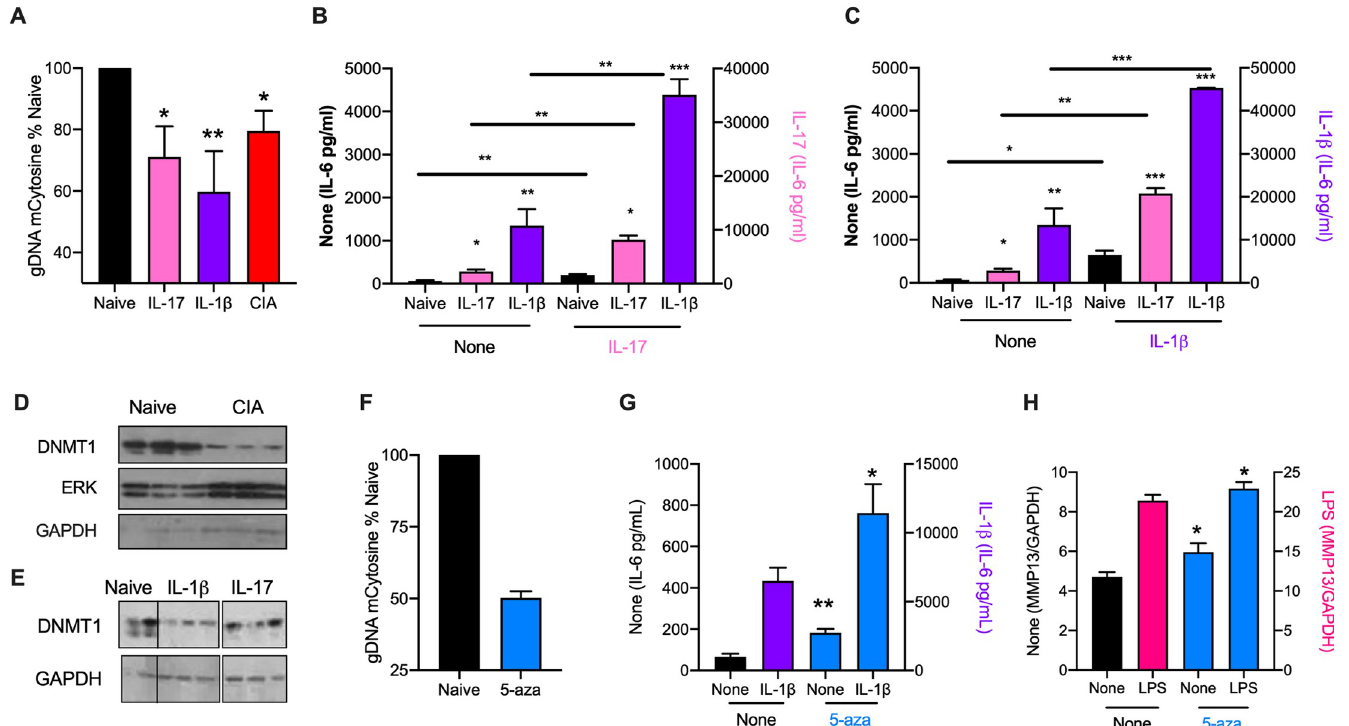
Fig 2. IL-1 β and IL-17 rewire na ï ve SFs to a CIA-like phenotype. (A) Global methylation status of Na ï ve-SFs incubated in medium alone (Na ï ve) or chronically treated with IL-17 or IL-1 β , compared to that of CIA-SFs. Data (means ± SEM) are from 3–5 independent experiments, normalized to “Na ï ve” controls. � p < 0.05 and �� p < 0.01 are relative to Na ï ve-SFs. The CIA-SFs were from 3 independent models (articular scores: 3.6 ± 1.5, n = 6; 4.5 ± 1.3, n = 10 and 2.5 ± 0.8, n = 12). ( B and C) Na ï ve-SFs incubated in medium alone (Na ï ve) or chronically treated with IL-17 or IL-1 β were re-challenged with medium (None; B and C ), or medium containing IL- 17 ( B ) or IL-1 β ( C ) and levels of IL-6 release determined. Data are means ± SEM of n = 3 independent cultures, where � p < 0.05, �� p < 0.01 or ��� p < 0.001 are relative to the relevant Na ï ve-SF group (same control “None” data for B and C ). Data in B are representative of 2 independent experiments. ( D ) Western blot analysis of DNMT1 expression in Na ï ve- and CIA- (articular score 3.6 ± 1.5, n = 6) SFs: each lane represents independent cultures and data (means ± SEM) were quantitated (DNMT1/ GAPDH ratios normalized to Na ï ve controls) by ImageJ as Na ï ve, 1 ± 0.262 and CIA, 0.063 ± 0.004, �� p < 0.01. (E) Western blot analysis of DNMT1 expression in Na ï ve-SFs chronically treated with medium alone (Na ï ve) or containing IL-1 β or IL-17, where lanes represent individual cultures. The data were quantitated (DNMT1/ GAPDH ratios normalized to Na ï ve controls) by ImageJ as Na ï ve, 1 ± 0.22; IL-1 β , 0.12 ± 0.02 and IL-17, 0.40 ± 0.14. (F-H) Na ï ve-SFs were chronically incubated in medium alone (None) or containing 5-aza and then assessed for (F) global DNA methylation status, (G) IL-6 release in response to IL-1 β challenge and (H) MMP13 mRNA levels in response to LPS-stimulation. Data are presented as means ± SEM, where n = 3 independent cultures ( F and G ) or means ± SD, n = 3 triplicate analyses ( H ) and � p < 0.05 or �� p < 0.01 relative to the appropriate sample lacking 5-aza (“None”).